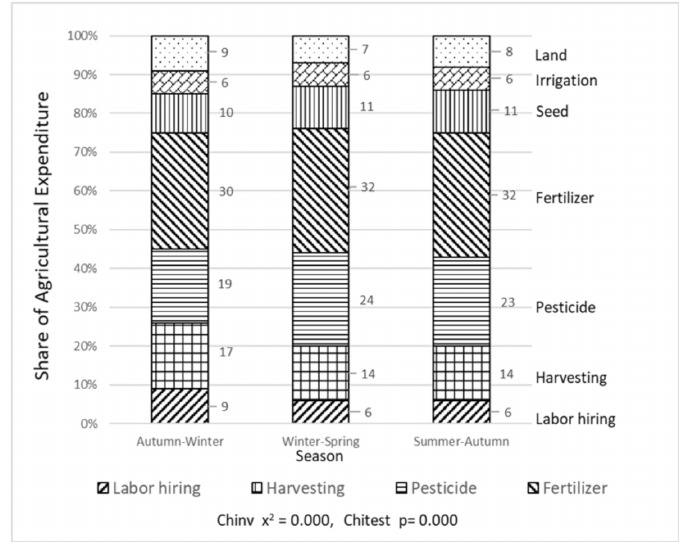
Figure 13. Share of rice cultivation expenditures. Results of interview with farmers. We conducted a Chi-square test and the results revealed significant di ff erences among written conditions. The harvesting cost of the Autumn–Winter season is bigger than other seasons because it includes a manual harvesting area. Source: Authors’ survey.